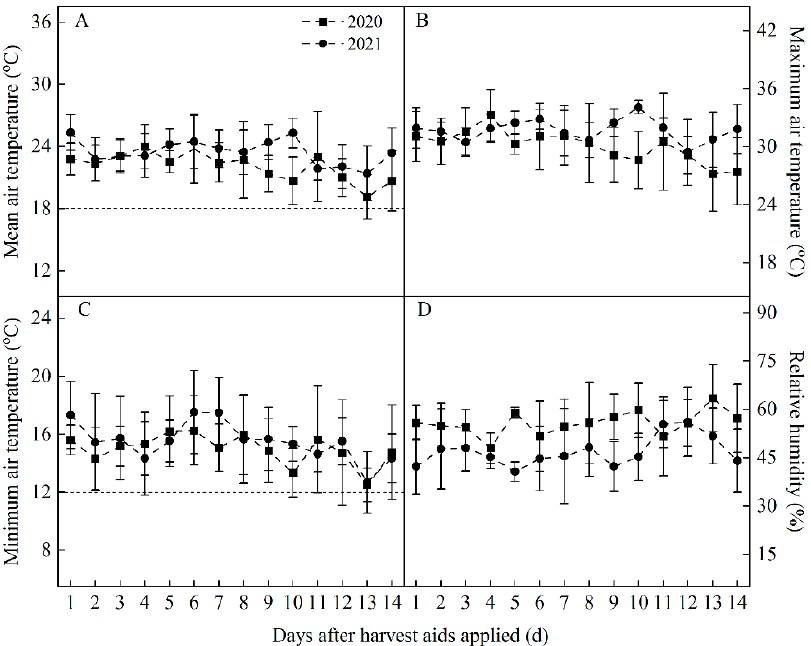
Figure 1. Weather data 14 d after the application of the harvest aids in 2020 and 2021. ( A ). Daily average temperature. ( B ). Maximum daily air temperature. ( C ). Daily minimum temperature. ( D ). Daily relative humidity.